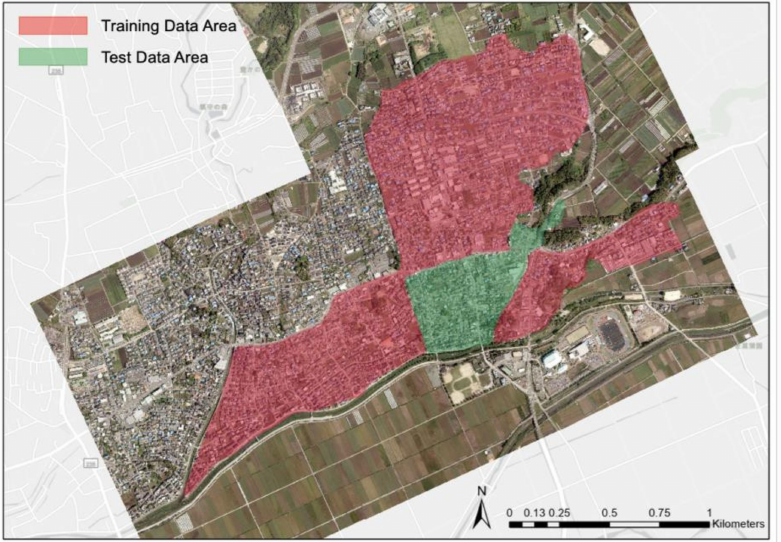
Figure 2. Training and test sets generated from the five high-solution aerial images taken by GSI on 29 April 2016